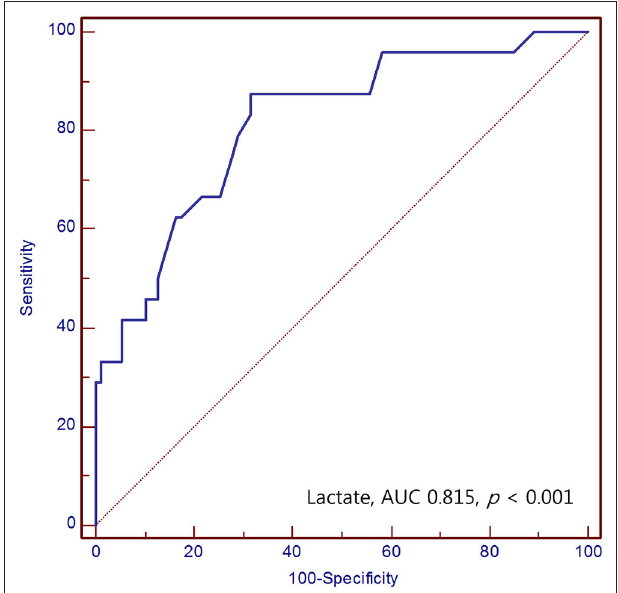
TABLE 2 | Multivariate analysis of various factors for predicting mortality in SAH. Multivariate analysis FIGURE 2 | Receiver operating characteristic curve of the serum lactate for predicting mortality of SAH patients in the emergency department. OR 95% CI